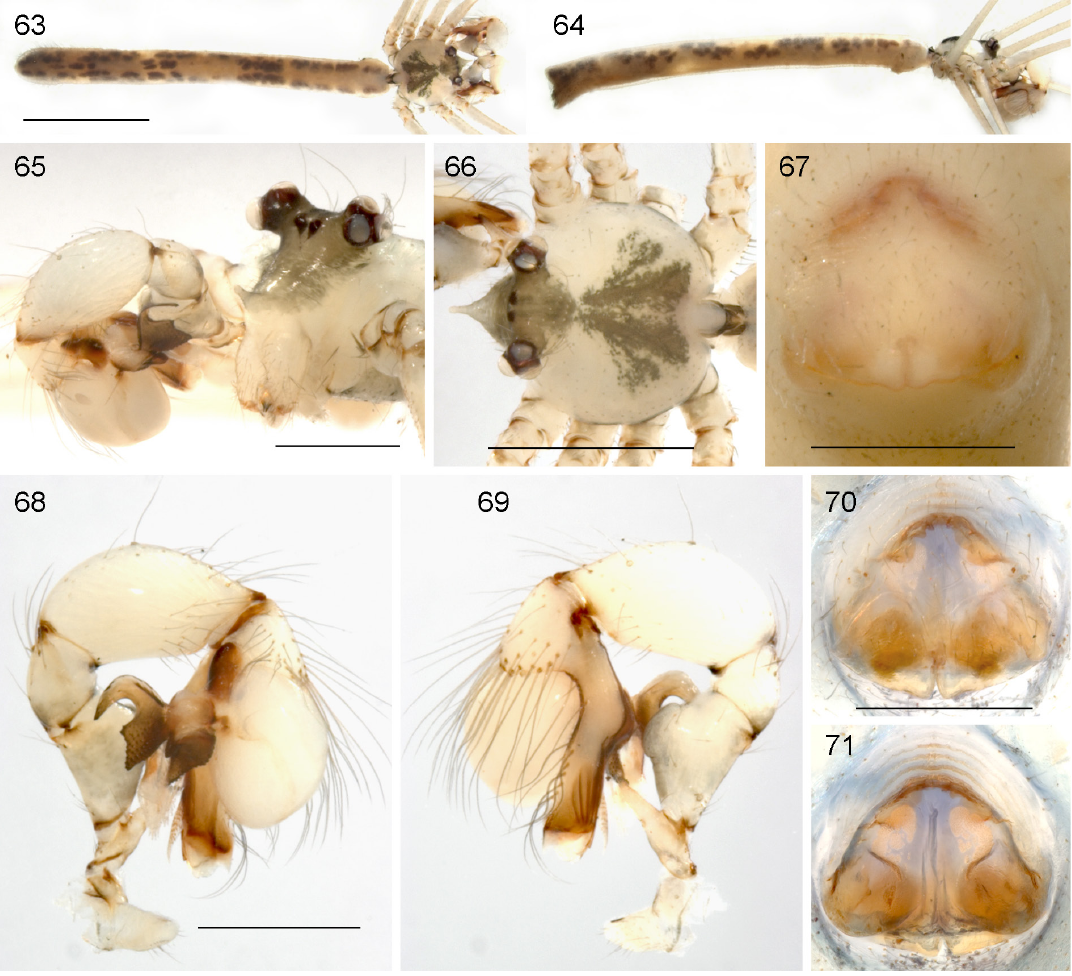
Figs 63-71. Leptopholcus kintampo sp. nov. 63-64 . ♂, dorsal and lateral views. 65-66 . ♂ prosoma, oblique frontal and dorsal views. 67 . Epigynum, ventral view. 68-69 . Left ♂ palp, prolateral and retrolateral views. 70-71 . Cleared ♀ genitalia, ventral and dorsal views. Scale lines: 63-64 = 2 mm; 66 = 1 mm; 65, 67-71 = 0.5